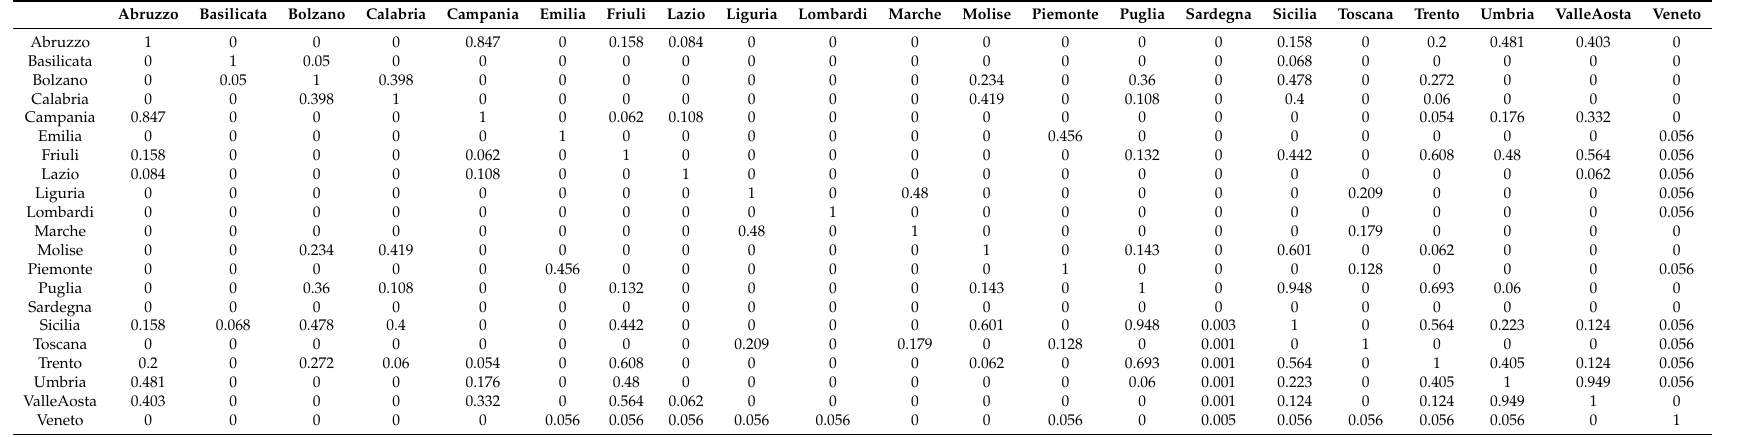
Table A10. Similarity values of Intensive Care network in the third